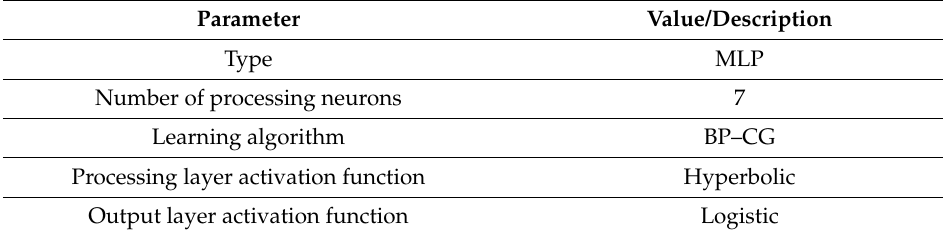
Table 3. ANN Model.